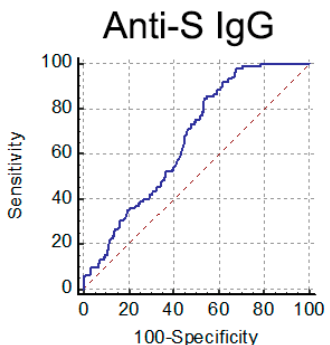
Figure 5. ROC curve analysis performed for anti-S IgG to detect high NAb titer ( ≥ 1:160) serum samples.